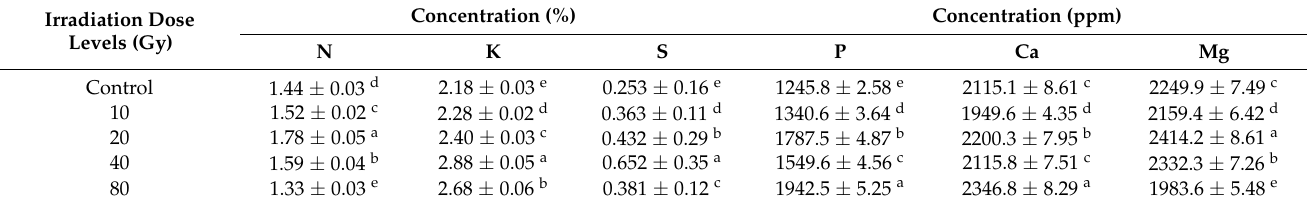
Table 4. Elemental composition of red radish roots affected by different doses of gamma-rays. Concentration (%) Concentration (ppm) Irradiation Dose Levels (Gy)